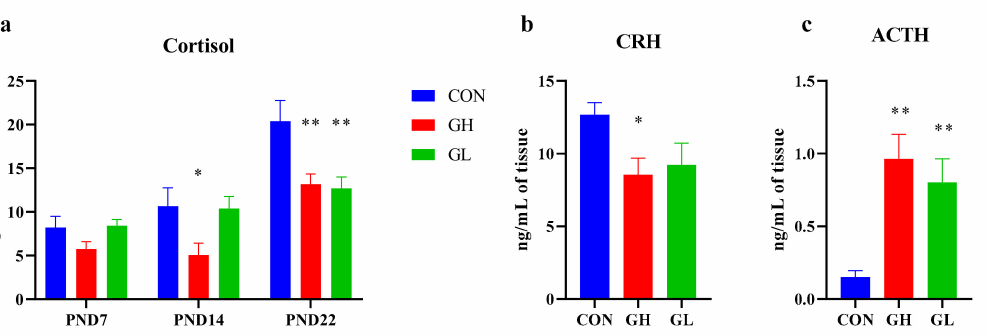
Figure 5. The levels of serum HPA axis hormones. ( a ) The serum COR level during lactation. ( b ) The serum CRH level on PND22. ( c ) The serum ACTH level on PND22. * significant differences vs. CON group, p < 0.05. ** significant differences vs. CON group, p <